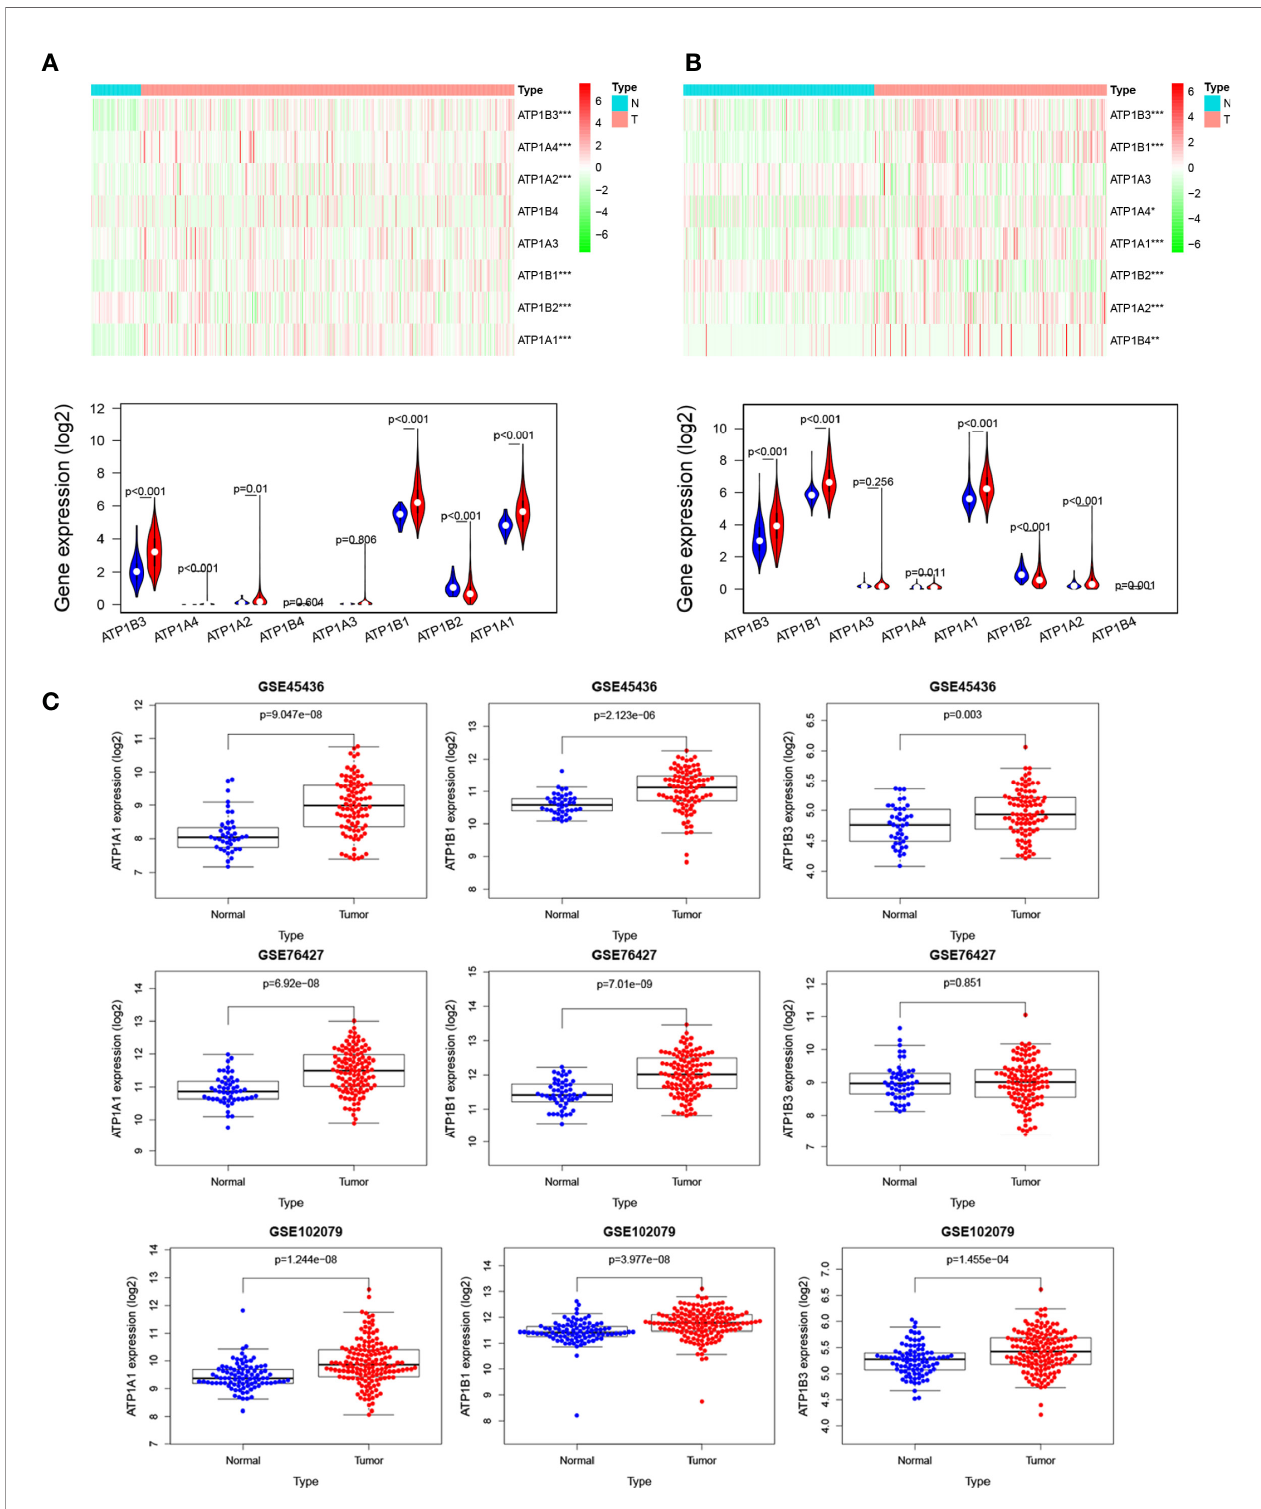
FIGURE 1 | NKA genes expression in HCC. The mRNA levels of NKA genes in HCC from (A) TCGA database. Up, heatmap. Down, Violin plot, Red: HCC tissue; Blue: normal tissue. (B) ICGC database. Up, heatmap. Down, Violin plot, Red: HCC tissue; Blue: normal tissue. (C) The mRNA levels of ATP1A1, ATP1B1, and ATP1B3 in HCC from four independent GEO datasets (GSE45436, GSE76427, GSE64041, and